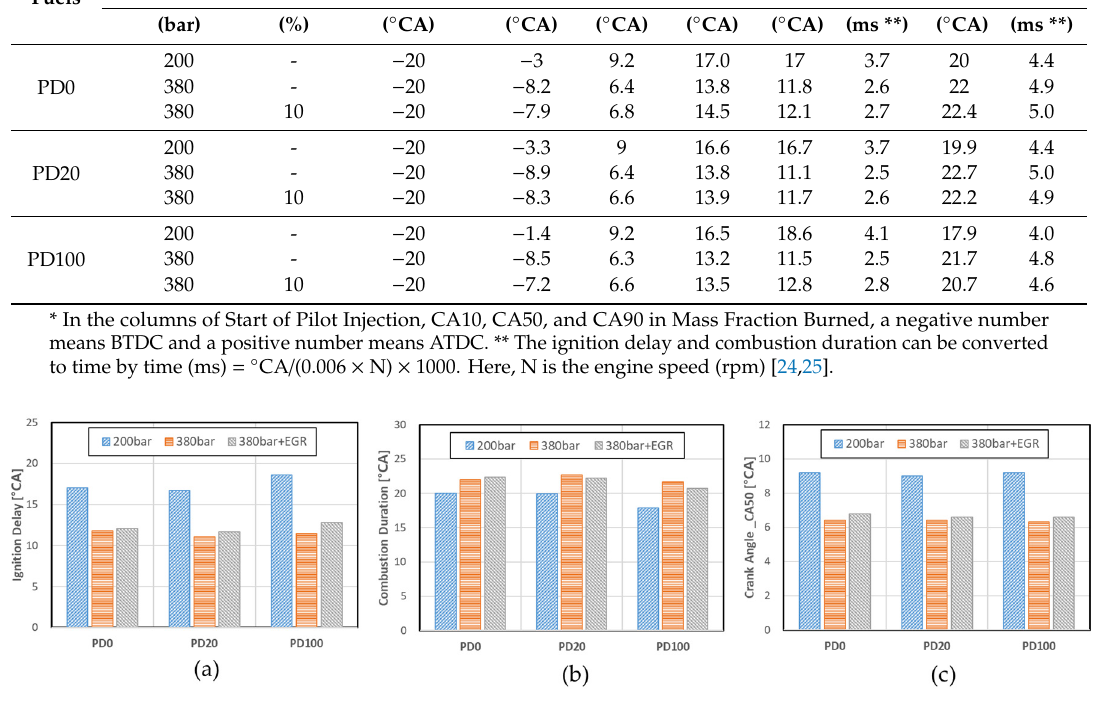
Figure 6. Mass Fraction Burned. ( a ) Ignition delay, ( b ) combustion duration, and ( c ) CA50.